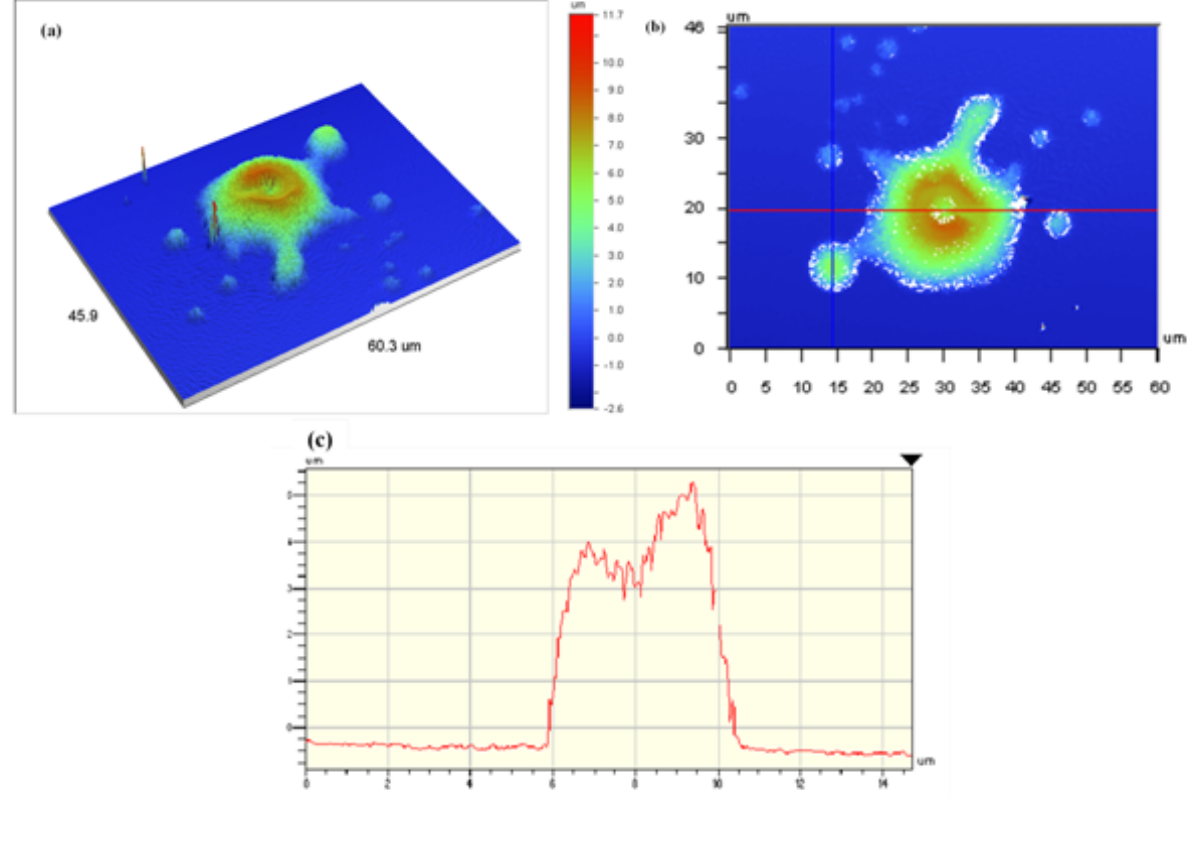
Figure 13. Splashed splat scanned by WYKO surface profiler ( a ) 3D display; ( b ) Top view; ( c ) Cross section of